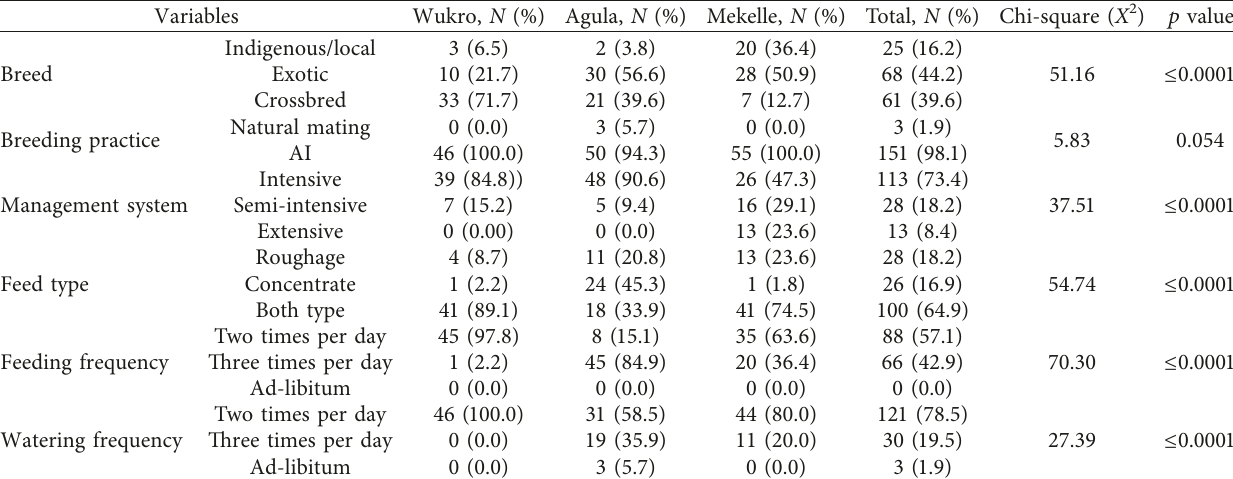
Table 3: Farmers’ practices regarding the farm management system in the study